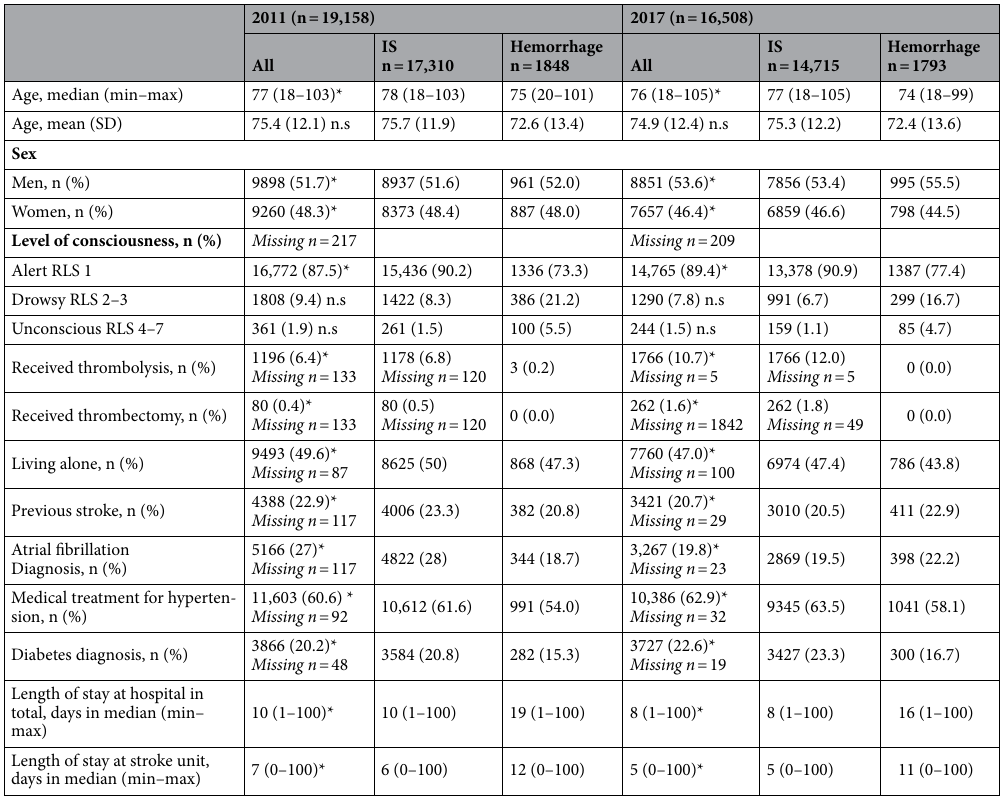
Table 1. Characteristics of the participants. IS ischemic stroke, RLS reaction level scale, SD standard deviation, n.s no significant difference between value from 2011 to 2017. Significance levels for differences between the study populations from 2011 and 2017: *indicates p < 0.001. Pearson’s χ 2 test (dichotomized variables) and Mann–Whitney U-test (continuous variables) were used for analysis.